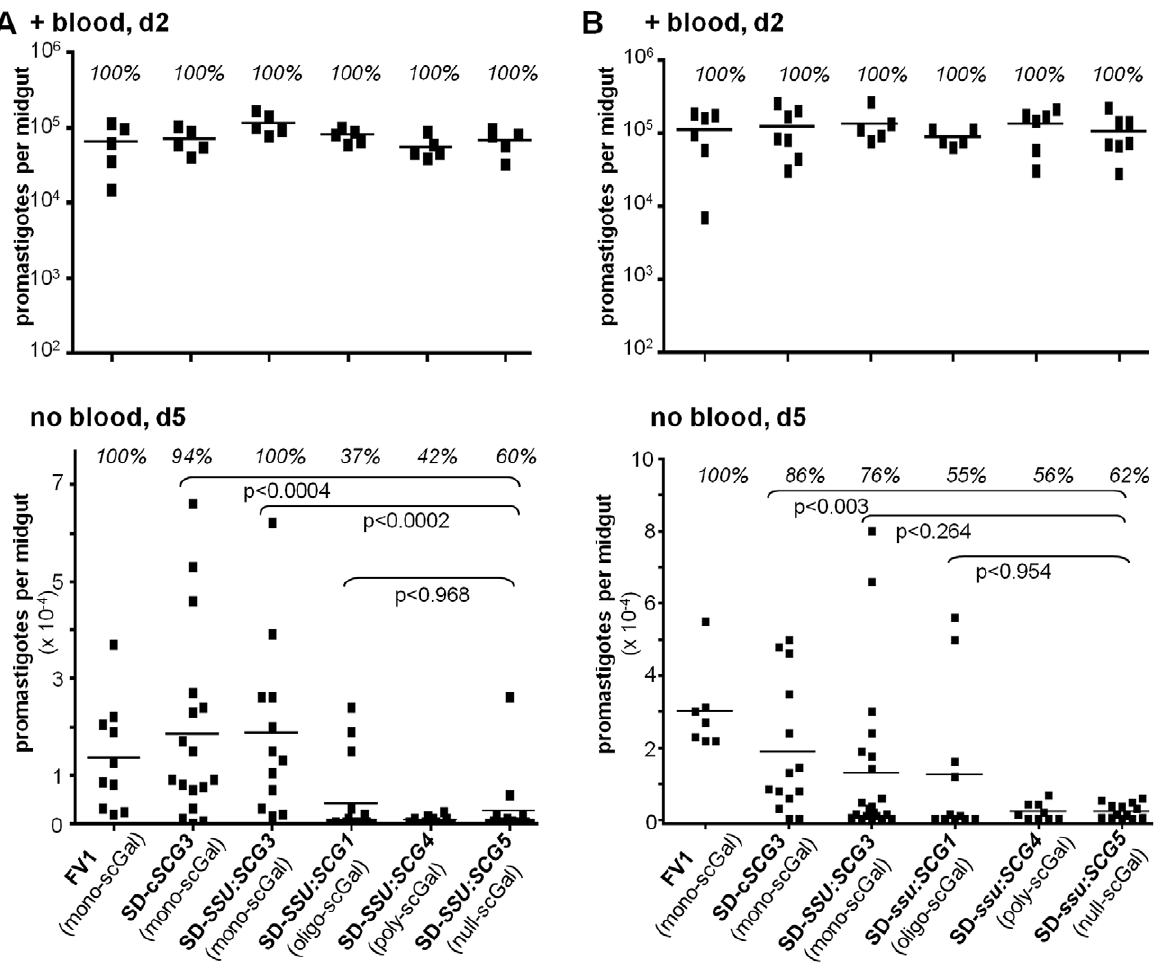
Figure 2. Survival of L.major SD- SCG transfectants in Ppap J sand flies is dependent on expression of specific scGal-LPG PAMPs. Female Ppap J flies were membrane fed on the indicated L. major -infective mouse blood and the number of viable parasites per midgut determined on the indicated day post-feeding as described in Fig. 1. SD-transfectant lines are described in the text, with additional data in Table S1. Infective mouse blood contained 5 6 10 6 (panel A) or 10 6 10 6 (panel B) parasites per ml. Results from two independent experiments (panels A,B) are